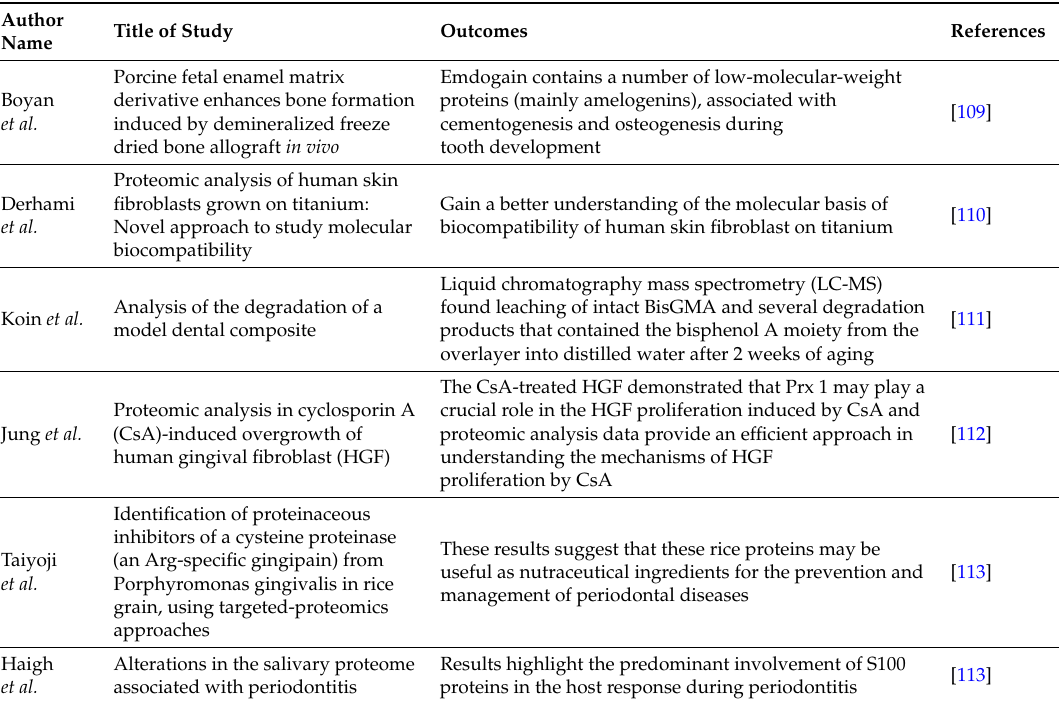
Table 3. Use of proteomics techniques for dental materials